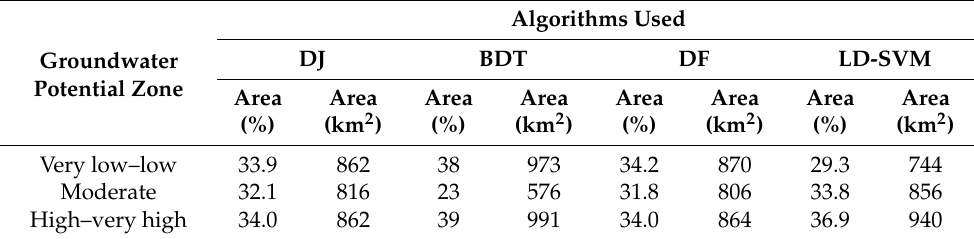
Table 4. Areas occupied by groundwater potential